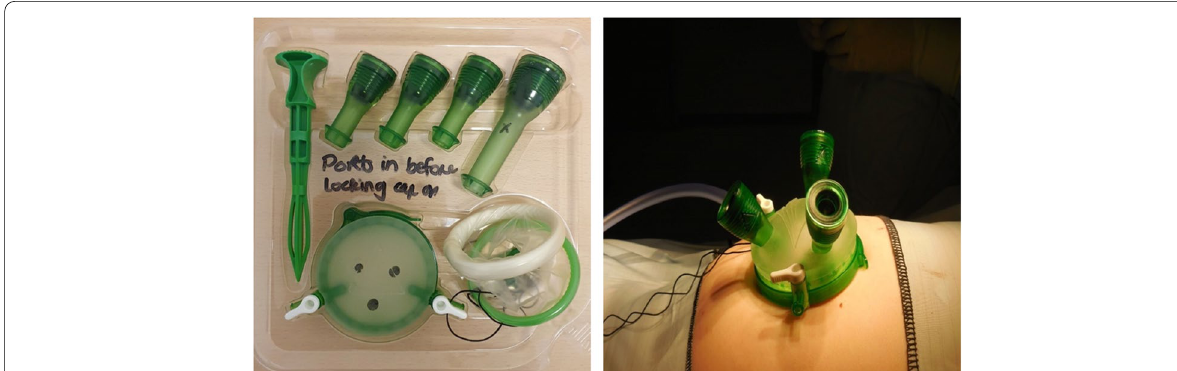
Fig. 1 GelPoint port in situ with pneumoperitoneum established